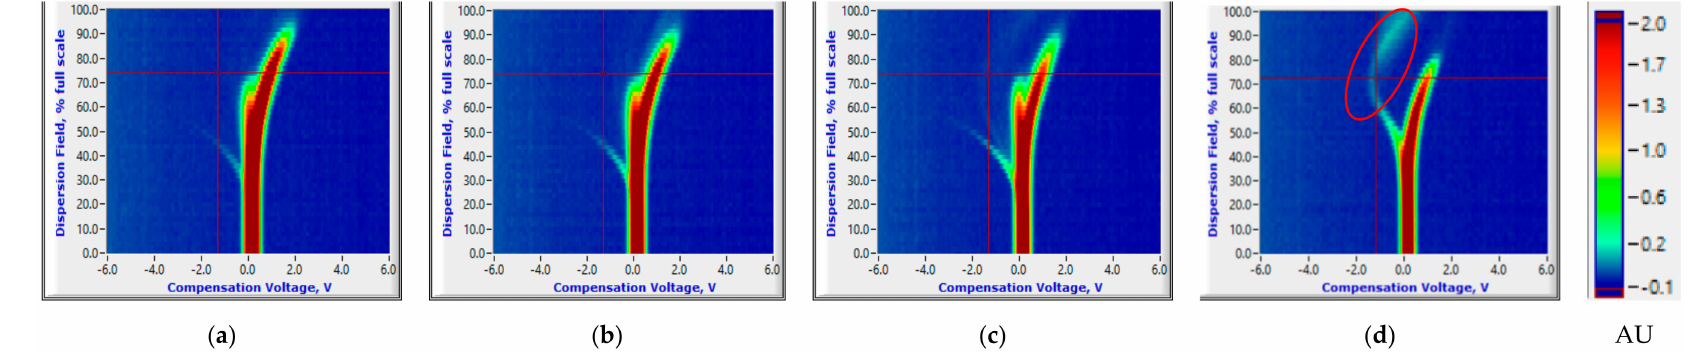
Figure 4. Ion current (AU) plots (corresponds to the color scale) at 0th (healthy control ( a ) and P. ultimum inoculated ( b )) and 14th (healthy control ( c ) and P. ultimum inoculated ( d )) days after inoculation for the Ranger Russet tuber sample replicates stored at room temperature (25 ◦ C).